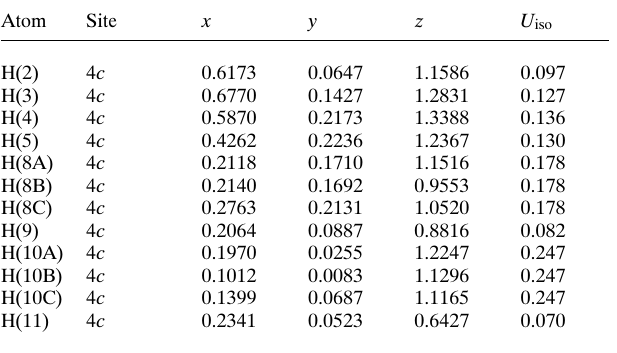
Table 2. Atomic coordinates and displacement parameters (in Å 2 ) .